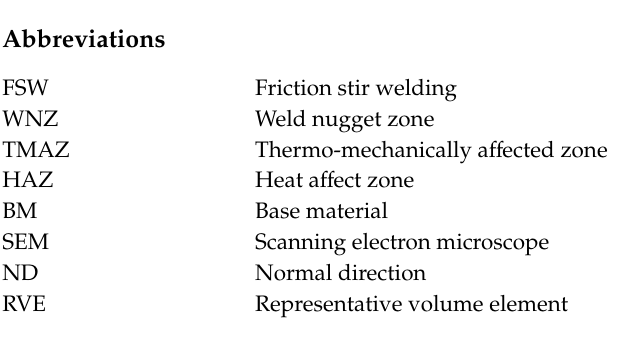
Figure 20. Distribution of principal strain in the WNZ including ( a ) cracked particles and ( b ) uncracked particles.